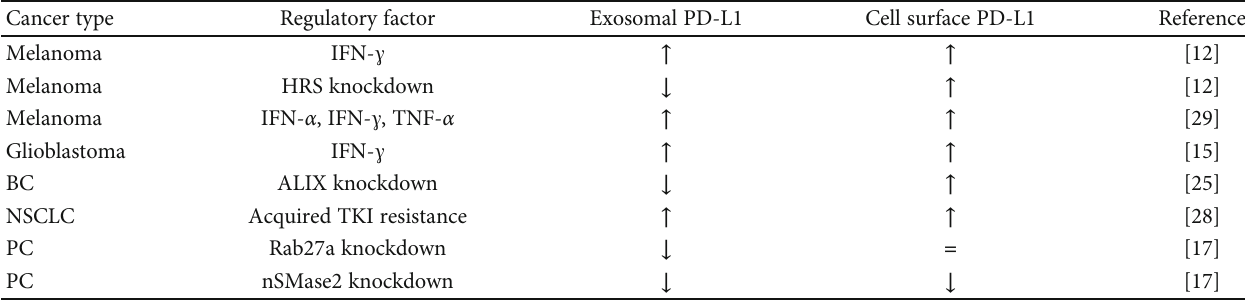
Table 1: PD-L1 subcellular distribution and associated regulatory